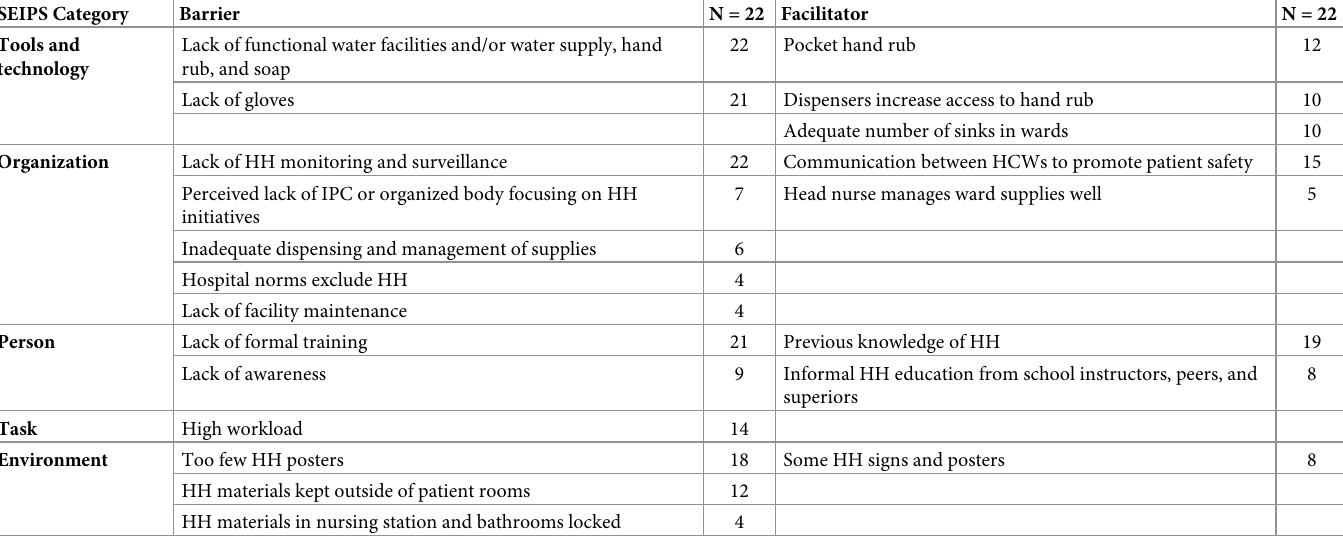
Table 3. Identified barriers and facilitators to HH classified within the SEIPS model’s 5 components of the work system: Tools and technology, organization, per- son, task, and environment. SEIPS